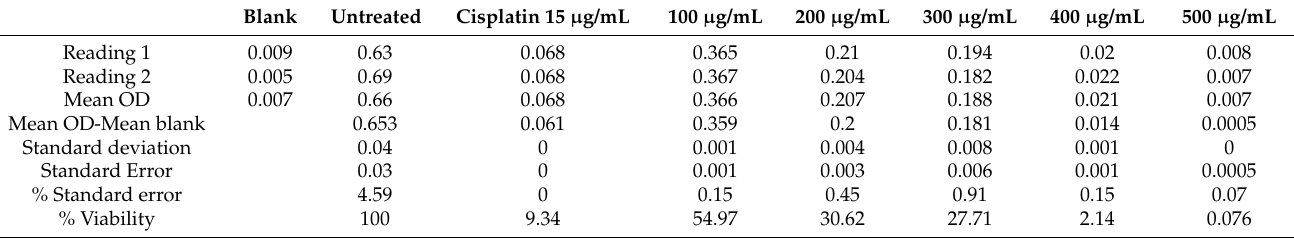
Table 6. Anticancer activity of C. limon extracts.